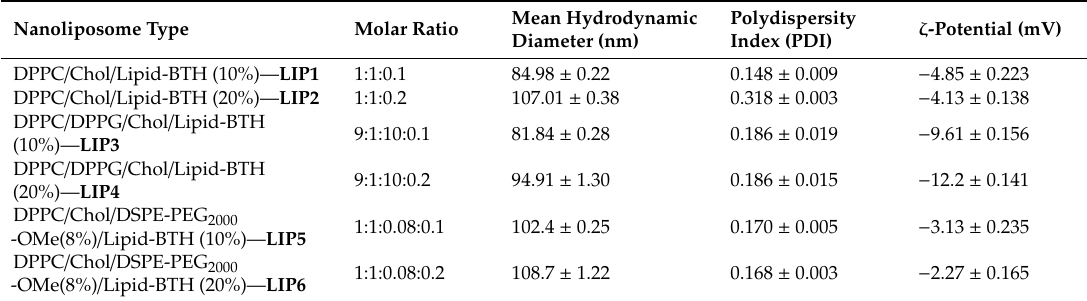
Table 1. Nanoliposome types, molar ratios of composition, and physicochemical characteristics. The vesicle mean diameter (nm), Polydispersity index and ζ -potential (mV) values reported, are the mean values from at least 5 measurements of 3 di ff erent preparations, in each case. The % percentage (10% or 20%) of Lipid-BTH is expressed corresponding to DPPC